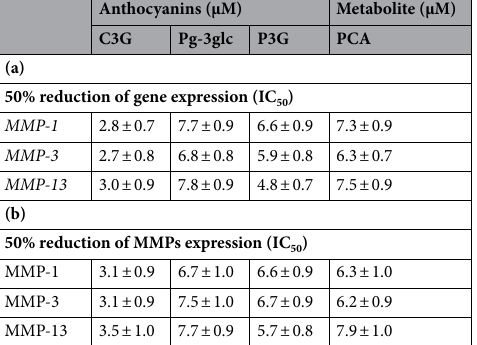
Anthocyanins (μM) Metabolite